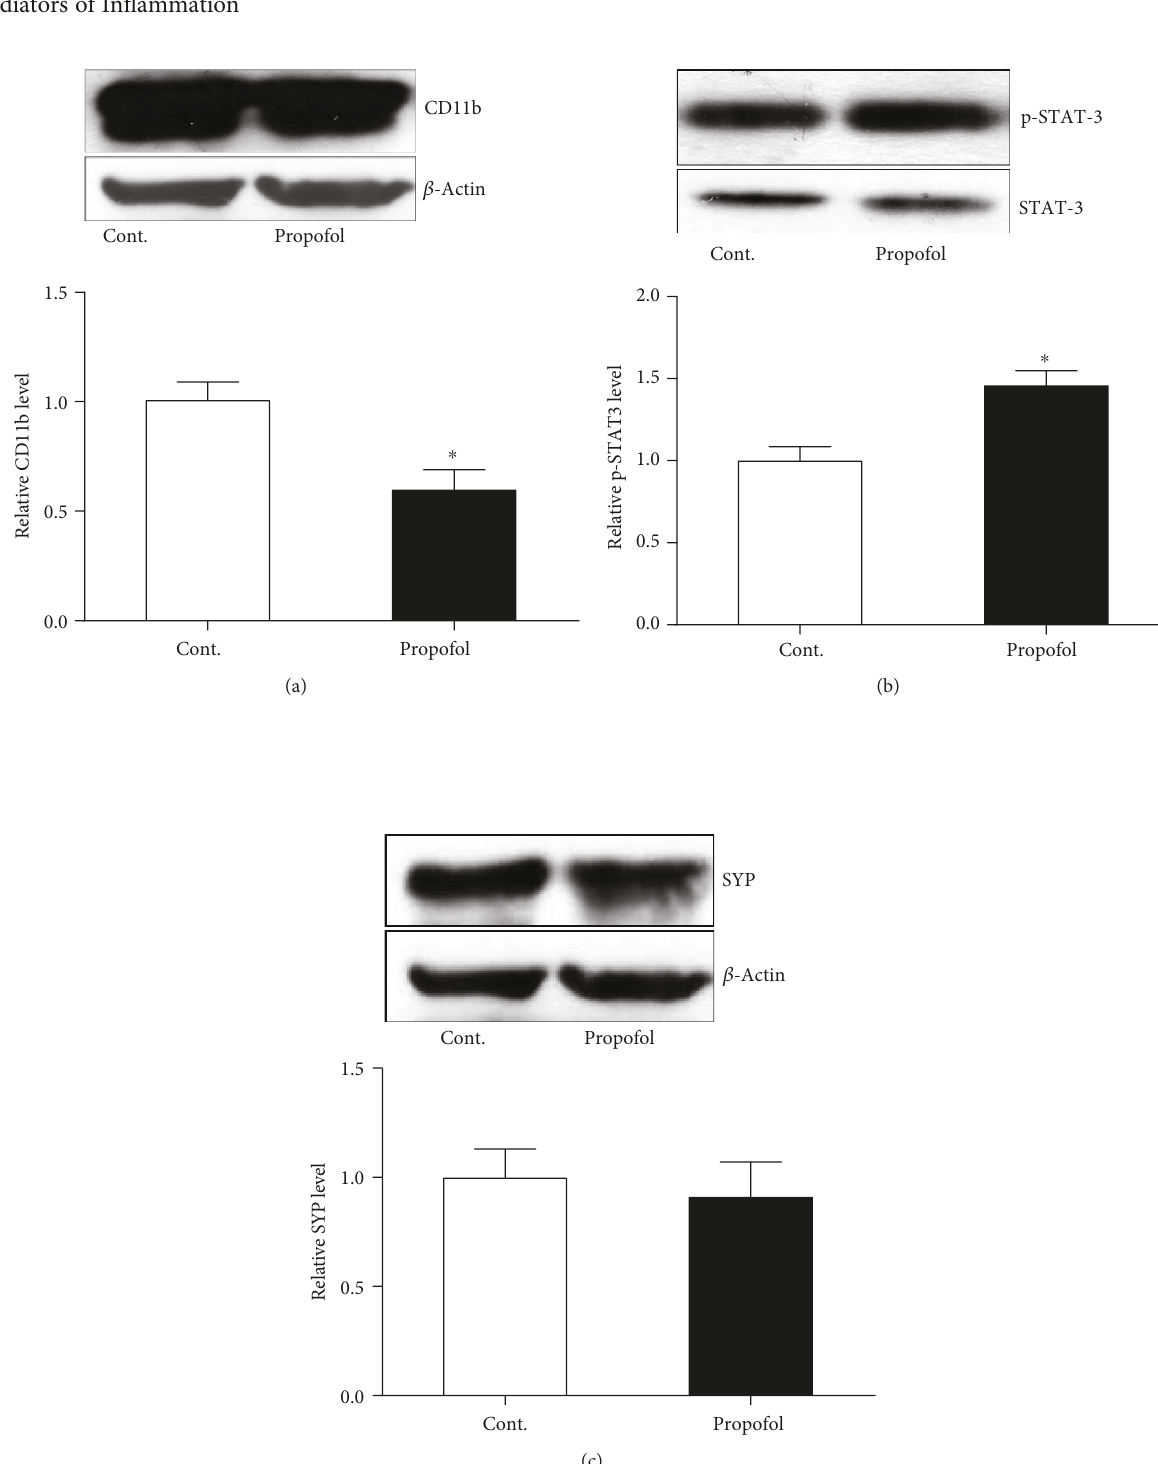
Figure 6: Propofol in fl uenced the function of astrocytes and STAT-3 in the brain tissues of mice compared to control mice. (a) Propofol decreased the expression of the CD11b protein in the brain of mice. (b) Propofol increased the expression of the p-STAT-3 protein in the brain of mice. (c) Propofol did not change the expression of the SYP protein in the brain of mice. All data are expressed as the means ± SEM . n = 5 . ∗ p < 0 05